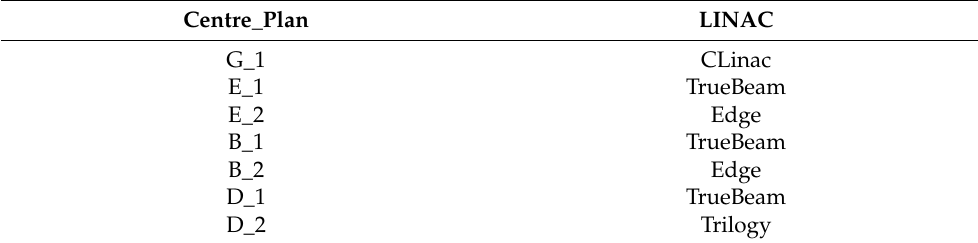
Table 2. List of centres that computed the IMRT dose distribution for the reproducibility and stability studies.